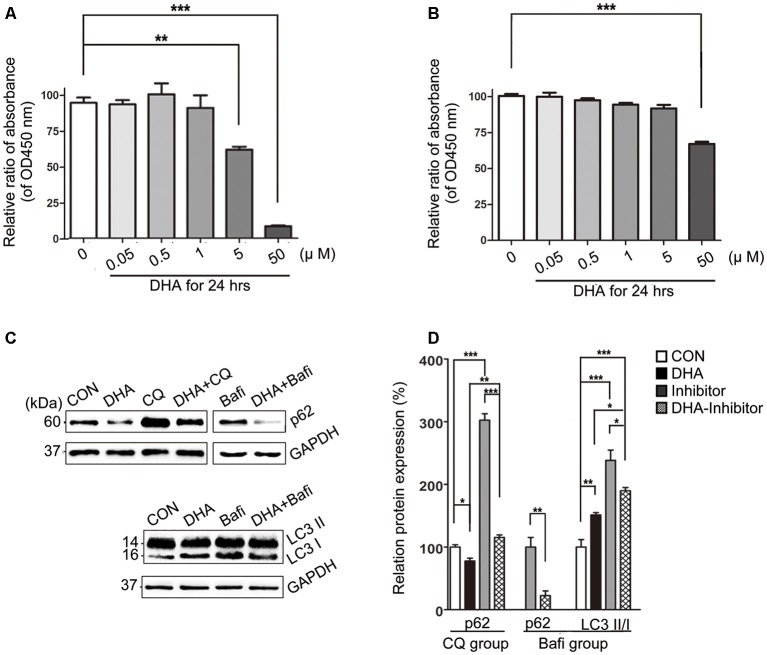
DHA ameliorates the protein levels of autophagic fusion and degradation processes. (A,B) DHA reduced the cell viability in a dose-dependent manner both in N2a-APP cells and APP-SH-SY5Y cells. The data are presented as the means ± SEM and were analyzed by one-way ANOVA (Newman–Keuls test, **p < 0.01, ***p < 0.001). (C) Protein levels of SQSTM/p62, LC3B I and LC3 II in cells in the CON group, DHA group, chloroquine (CQ) group, CQ-DHA group, Bafi group and Bafi-DHA group were detected by WB. Representative Western blots are presented in panels (C), and quantification of the results is shown as the mean values ± SD in panels (D). *p < 0.05, **p < 0.01, and ***p < 0.001 between two groups. One-way analysis of variance/Newman–Keuls test was performed for all WB data.